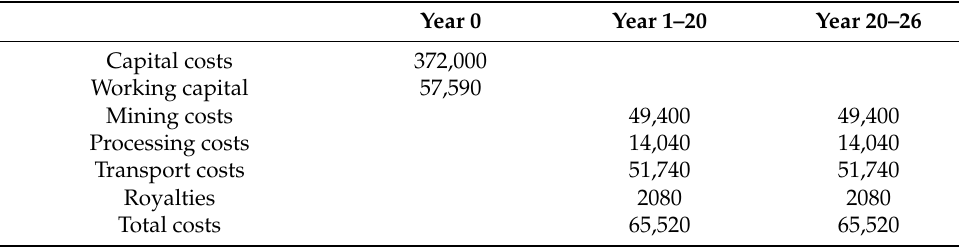
Table 5. Cash-flow calculation in